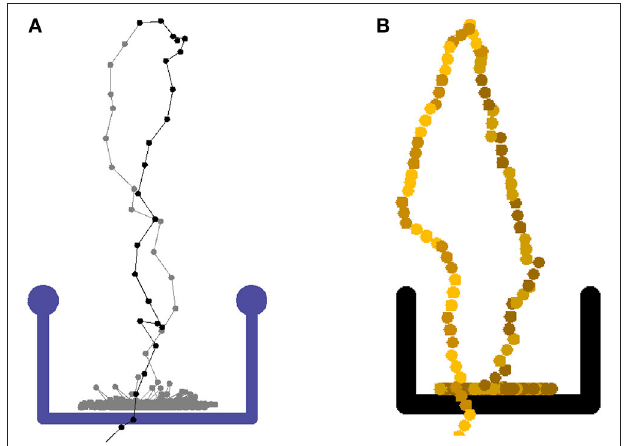
FIGURE 7 | (A) Snapshot from a simulation of the chain fountain with separated beads and (B) the pasta model. The latter is designed to optimize the kick-off effect. Both simulations correspond to the experiment done by Biggins [ 4].